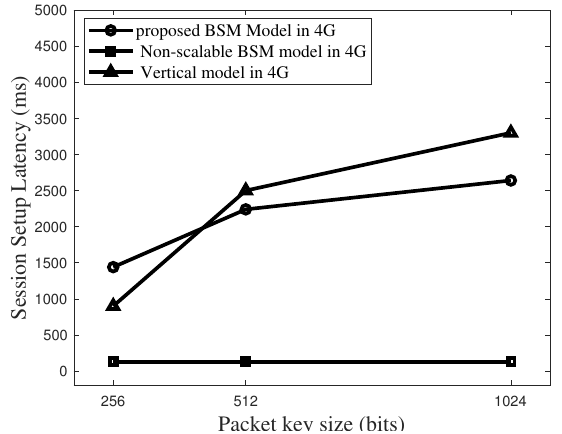
Figure 18. Total latency to set up a packet key-based secure session in 4G networks for the case size of Blind Value Vector (m) = 400.